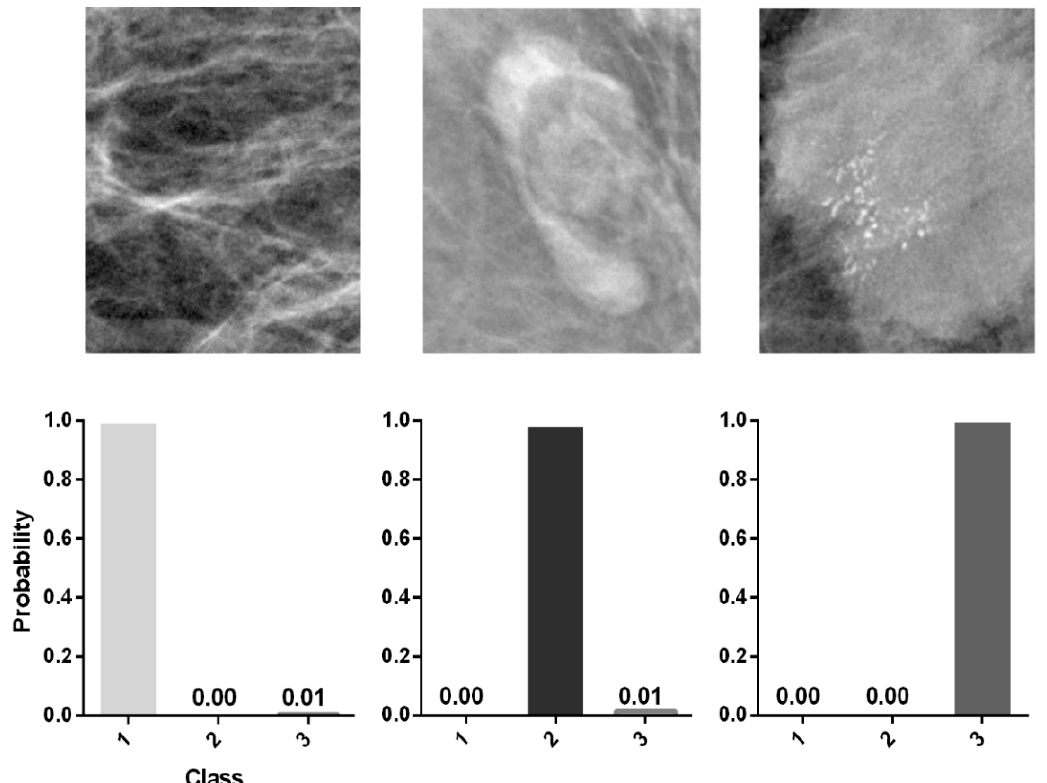
Figure 3. Representative mammograms of the 3 different classes (1, “breast tissue”; 2, “benign lymph nodes”; 3, “suspicious lymph nodes”) that were correctly classified by the trained dCNN according to the ground truth (radiological report).